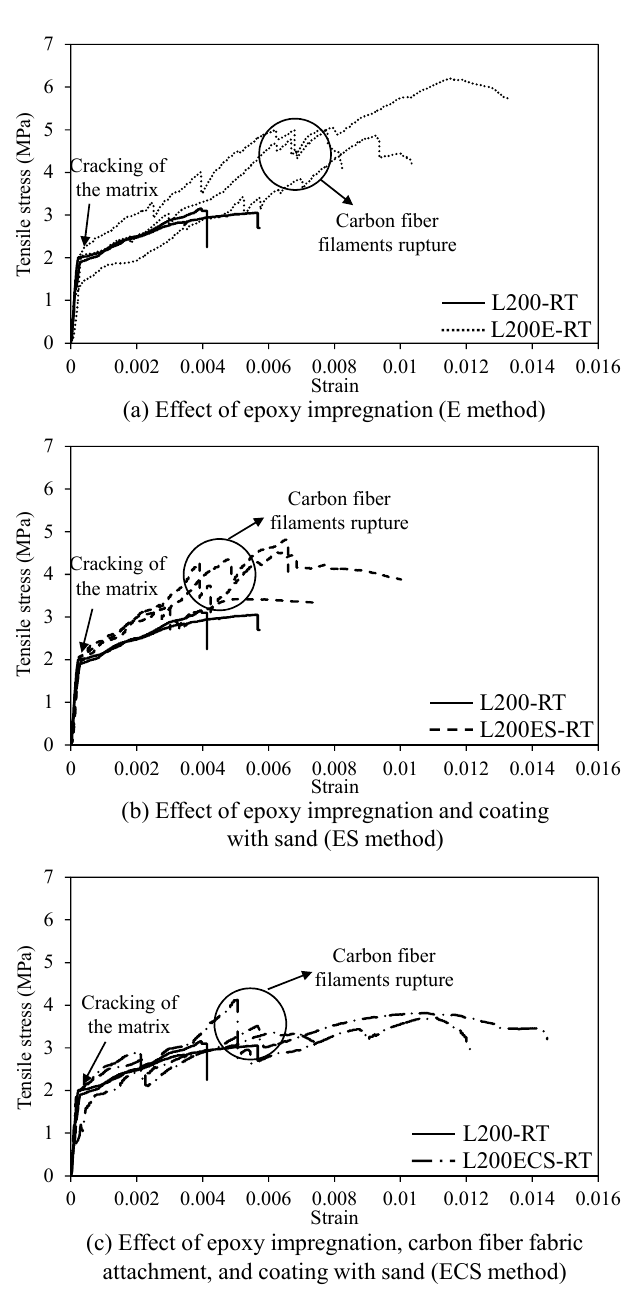
Figure 14. Stress–strain relationship of test specimens in the second series.